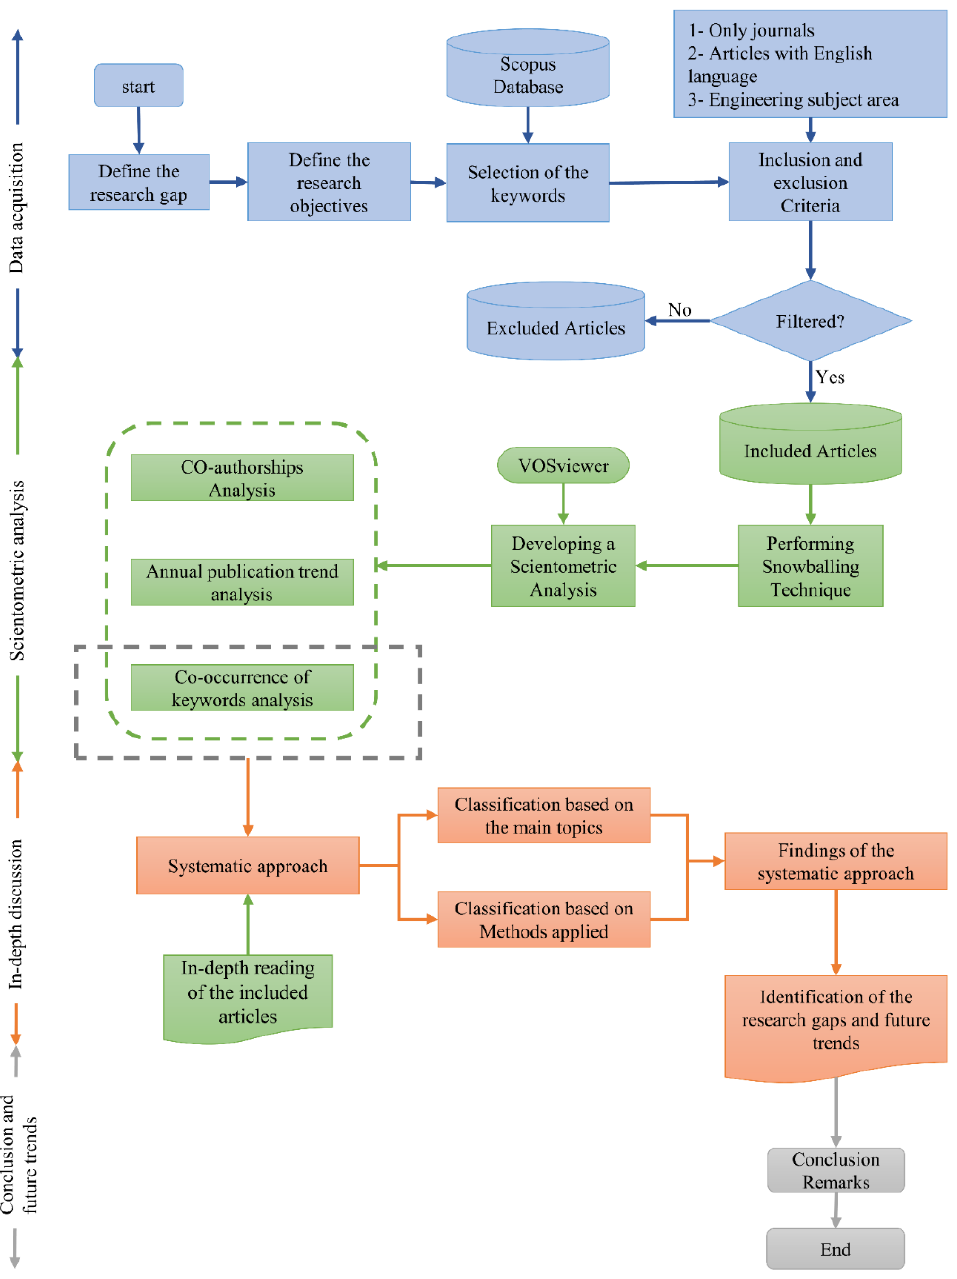
Figure 1. An outline of the research methodology.